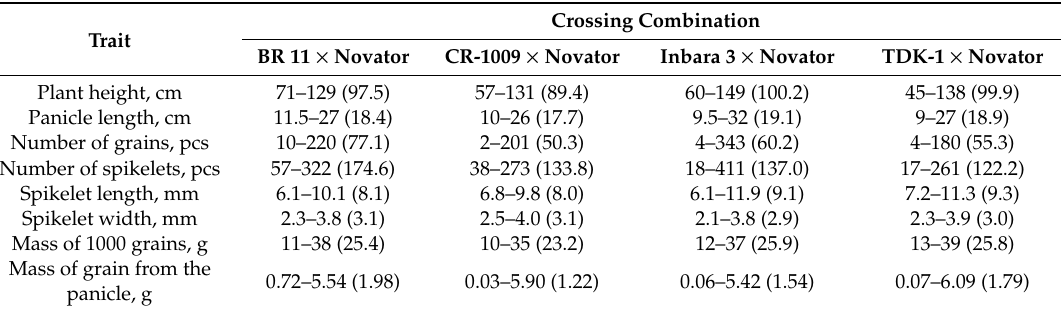
Table 2. Variations in the quantitative traits in F 2 hybrids from crossing submergence-resistant samples with the variety Novator,